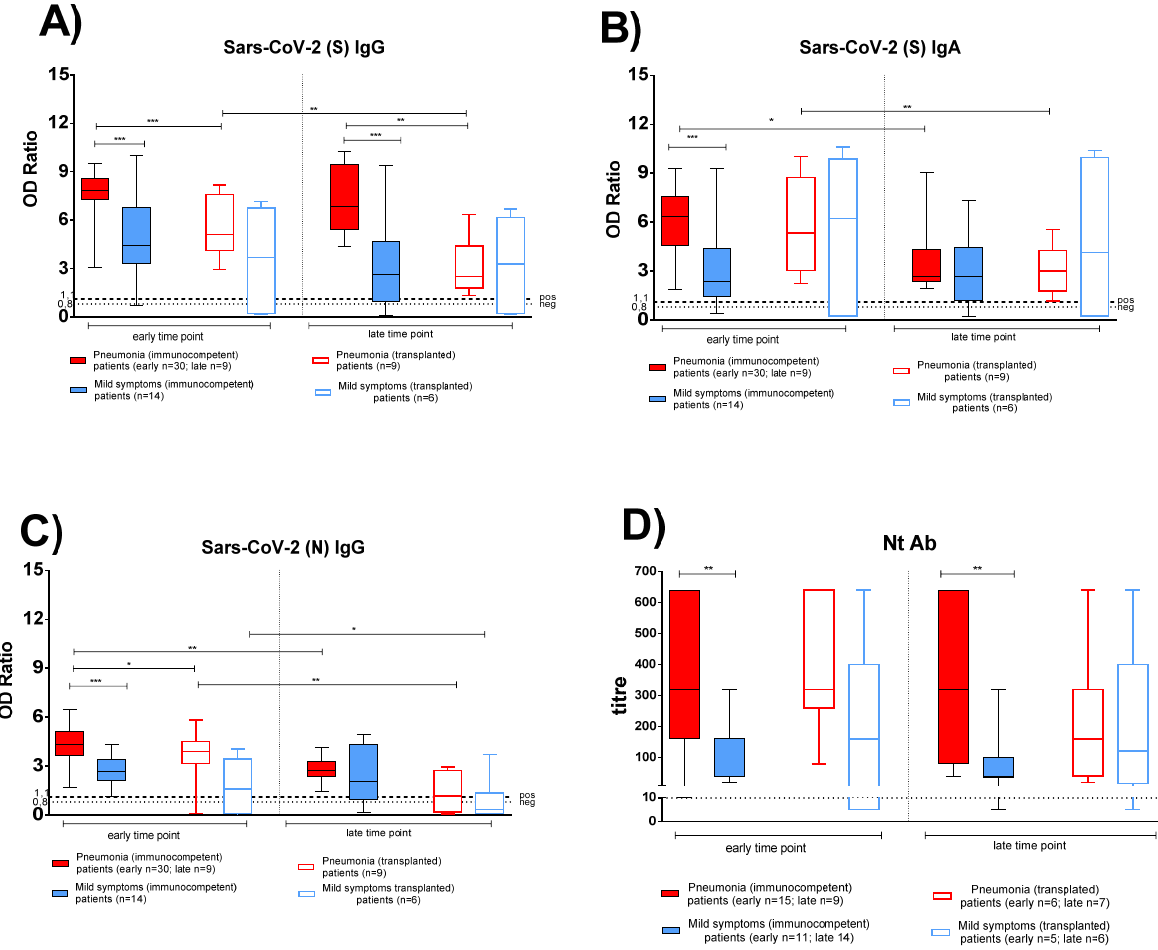
Figure 1. The antigen-specific antibody response was compared between immunocompetent (IC) and transplanted (TX) patients with pneumonia or mild symptoms at early and late time points. ( A ) Anti-Spike (S) IgG. ( B ) Anti-Spike (S) IgA. ( C ) Anti-Nucleocapsid (N) IgG. ( D ) Nt Ab. Early time point: patients with pneumonia, IC median 58 (range 45–100); TX